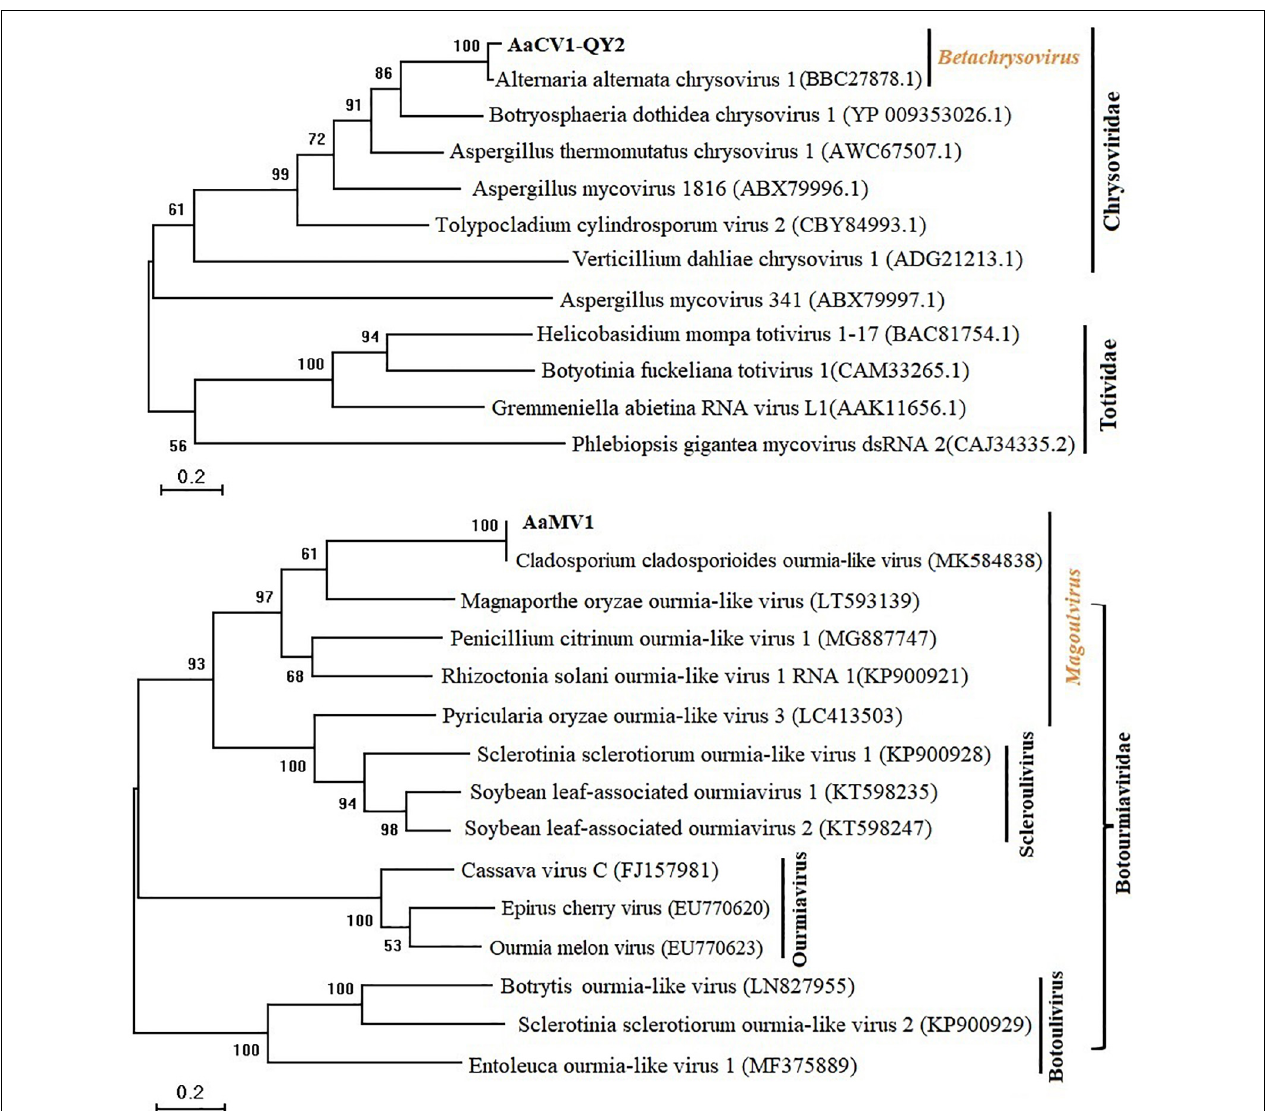
FIGURE 3 | Maximum likelihood (ML) phylogenetic tree based on the RdRps of AaCV1-QY2 (Upper) or AaMV1 (Lower) and other related viruses. The phylogenetic tree was generated using the software MEGA X. The bootstrap values (%) were obtained with 1,000 replicates. The scale bar at the lower left represents a genetic distance of